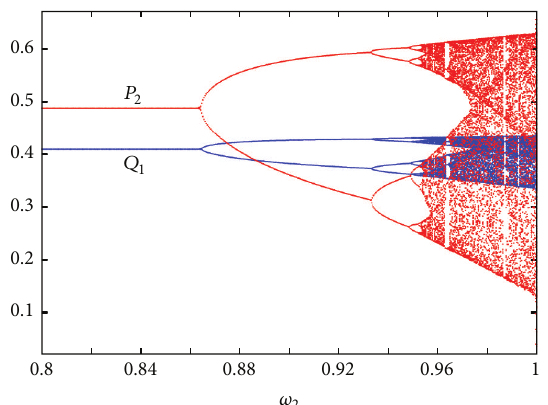
Figure 12: Bifurcation diagrams of system (11) for 𝛼 = 1.5 , 𝛽 = 2.9 and 𝜔 1 = 𝜔 2 = 𝜔 varying from 0.8 to 1